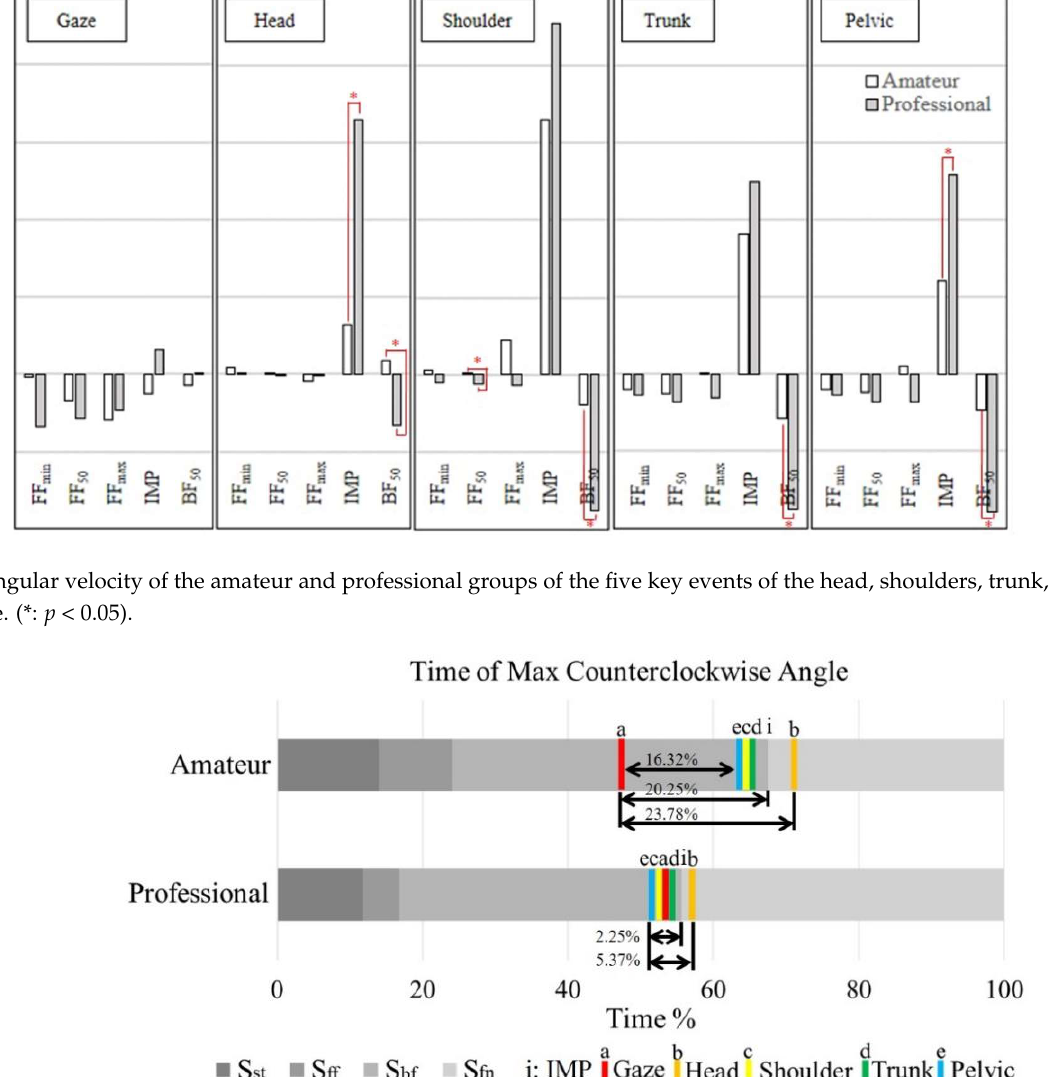
Figure 4. The angular velocity of the amateur and professional groups of the five key events of the head, shoulders, trunk, pelvis, and gaze. (*: p < 0.05).